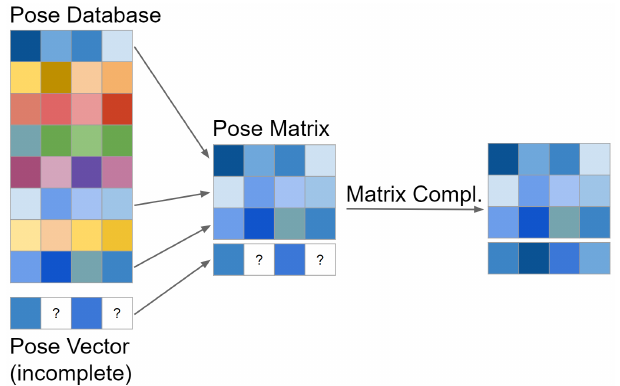
Figure 1. Given an incomplete pose vector (for example from a skeleton tracker) and a large database of natural human poses, we select a small subset of poses from the database based on their distance to the pose vector. This subset forms the “pose matrix”, to which we simply append the pose vector. By completing the resulting matrix, we obtain estimates for the missing joints’ locations.